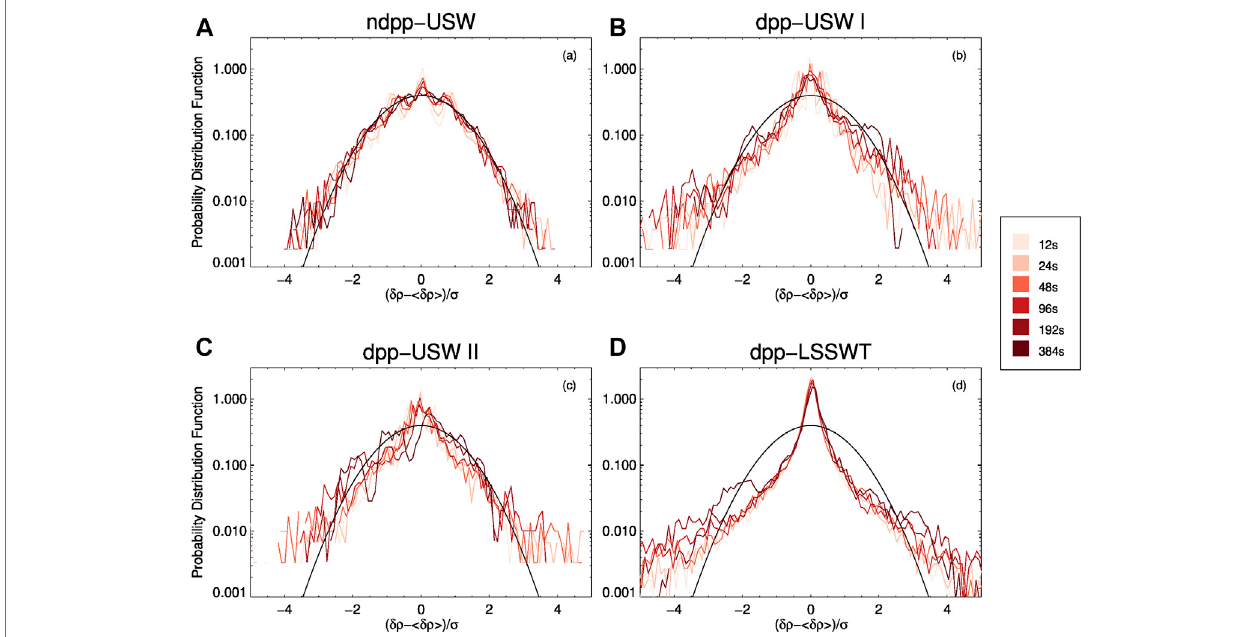
FIGURE 8 | Probability distribution functions of solar wind proton density increments normalized to the standard deviation for different time lags of ndpp-USW region (A) , dpp-USW Iregion (B) , dpp-USW IIregion (C) ,dpp-LSSWTregion (D) .The timeintervals offourdistinctregionsarepresentedin Figure7 .The blackcurveis the standard Gaussian distribution with unit variance. The different degrees of red lines illustrate the actual distribution function between different time lags ranging from 12 to 384 s.